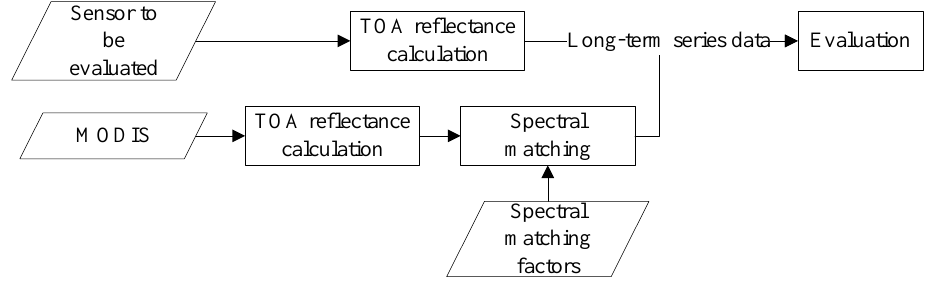
Figure 2. The block diagram of the framework for radiometric capability evaluation.